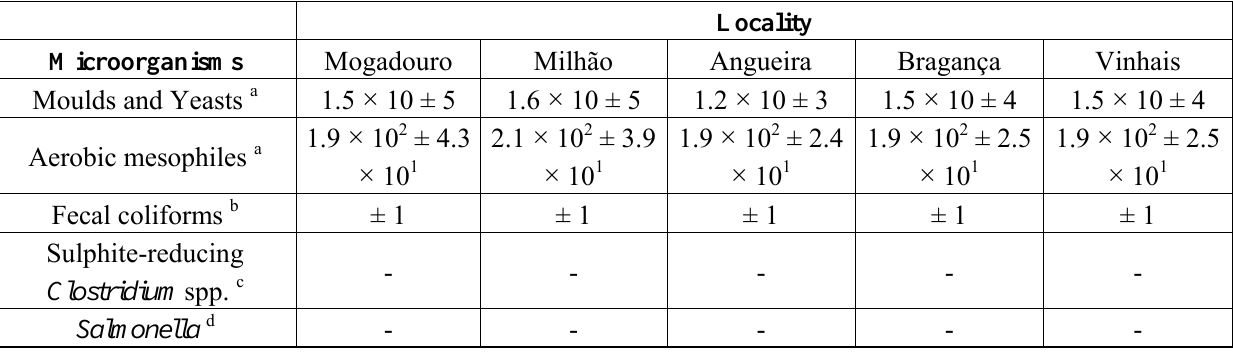
Table 4. Microbial analyses of organic honey